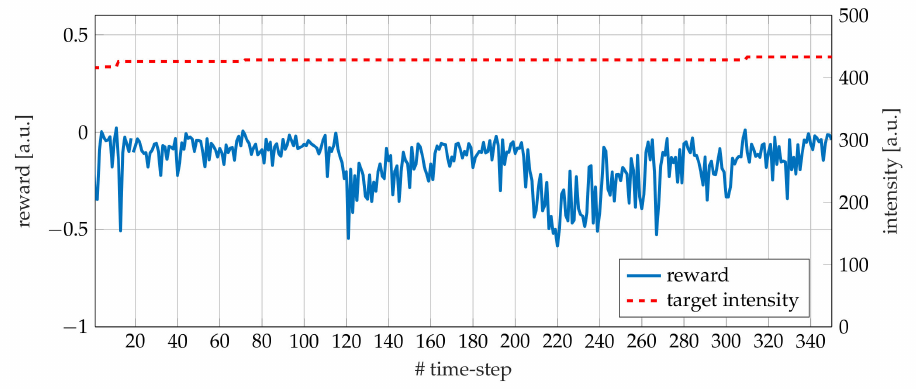
Figure 10. Reward (blue) and target intensity (red, dashed) during a single run of NPG REINFORCE on FEL. The slight increases of target intensity correspond to positive